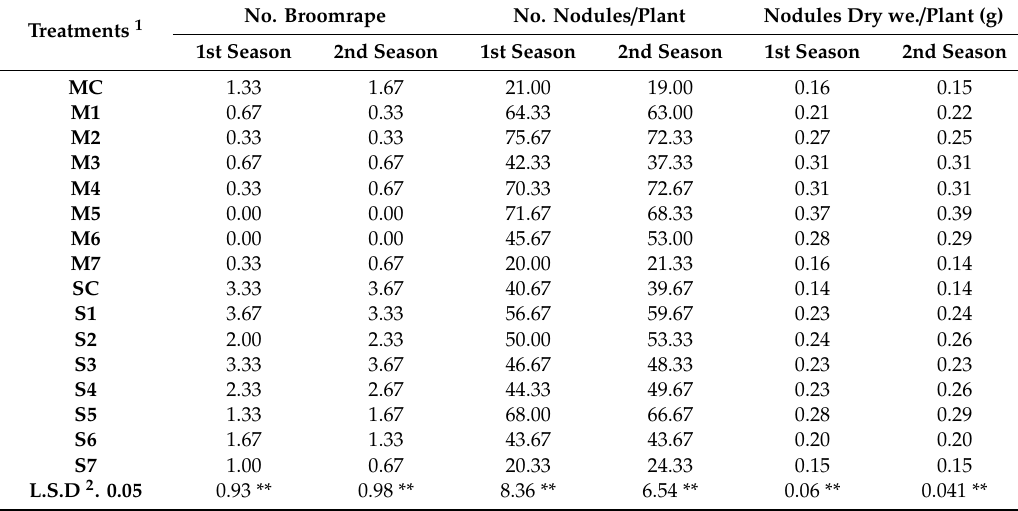
Table 6. E ff ect of spent mushroom substrate extract (SMSE), mushroom culture filtrate (MCF), and Roundup ® treatments to control broomrape infestation on broomrape number (No.), No. of Rhizobia nodules / plant, and Nodules dry weight (g / plant) at 60 days from sowing. Treatments 1